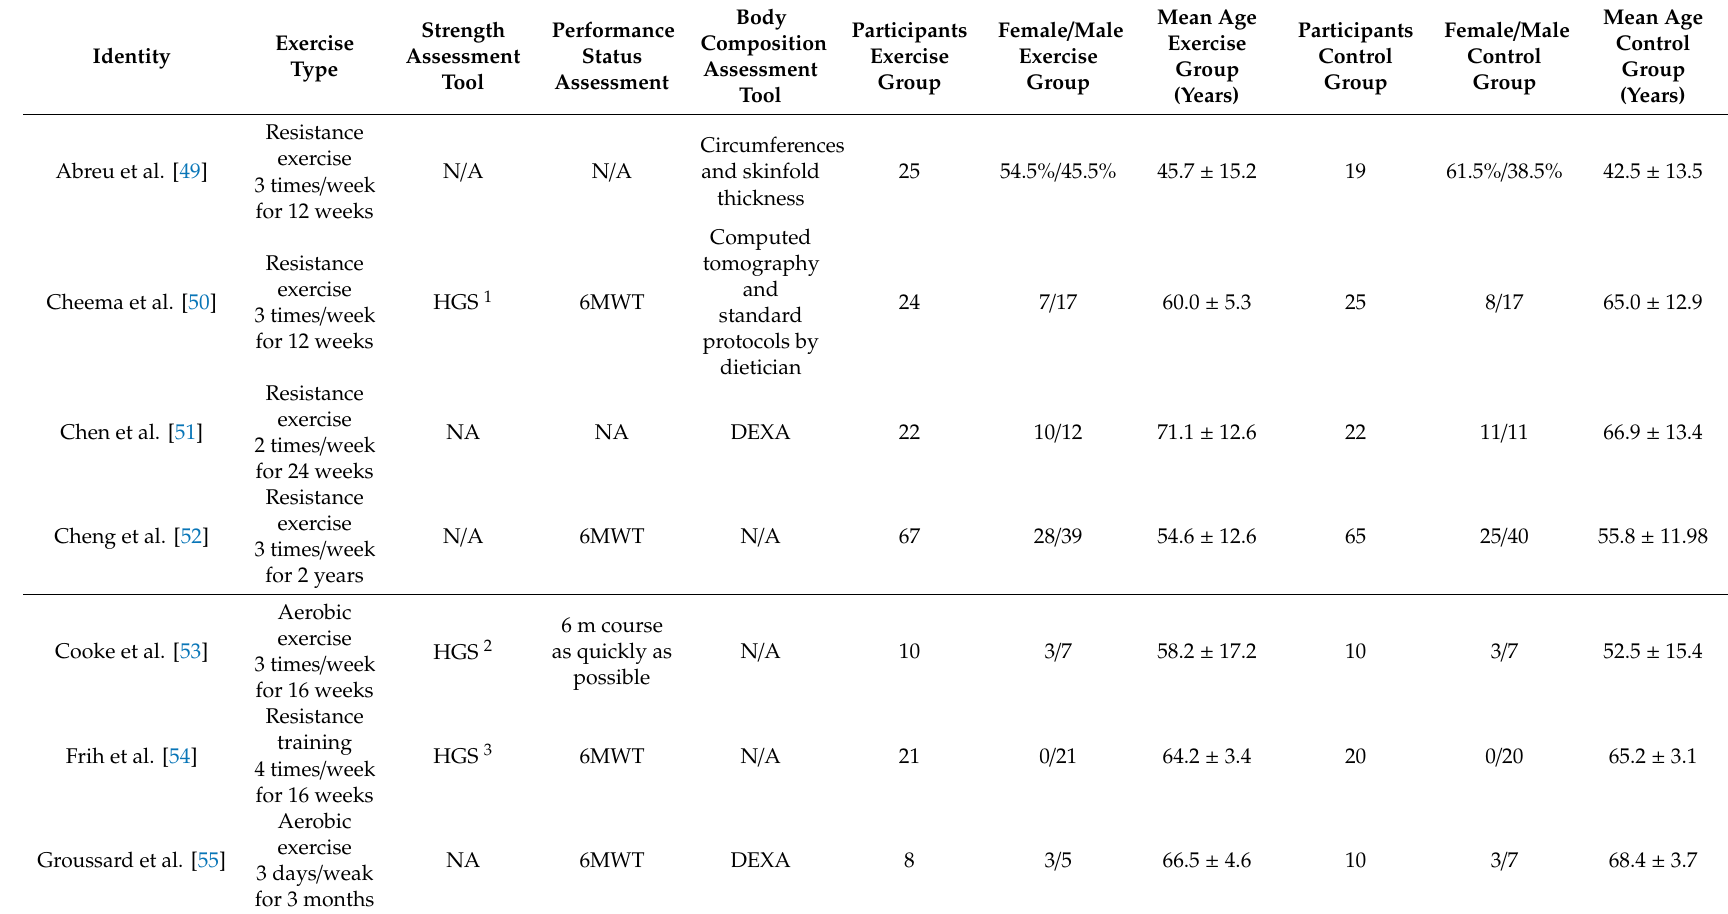
Table 1. Characteristics of included